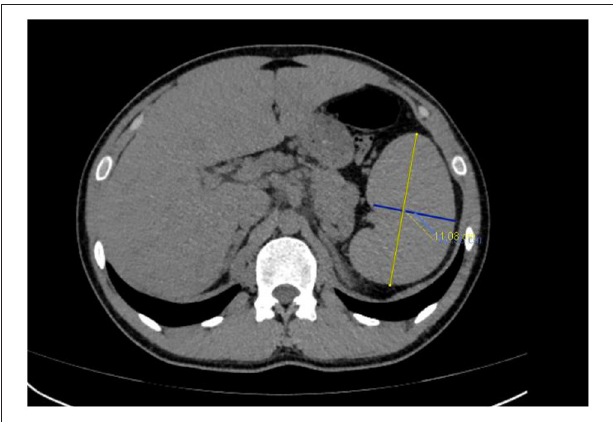
FIGURE 1 | Abdominal and computed tomography (CT) revealed splenomegaly.